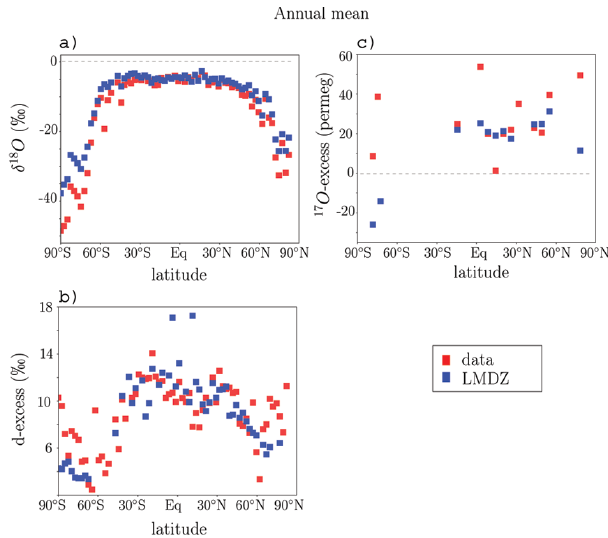
Fig. 4. Annual, zonal mean of precipitation δ 18 O , d-excess and 17 O -excess simulated by LMDZ, compared to the GNIP database for δ 18 O and d-excess and to the data listed in Tables 1 and 2 for 17 O -excess. The model outputs are collocated with the location and month of each